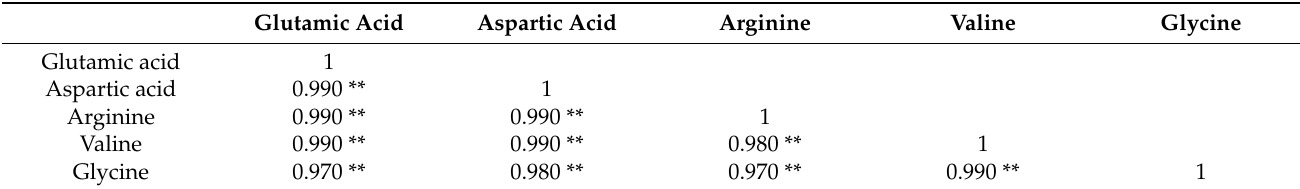
Table 4. Correlation coefficient of main amino acid components in sunflower seed kernels.